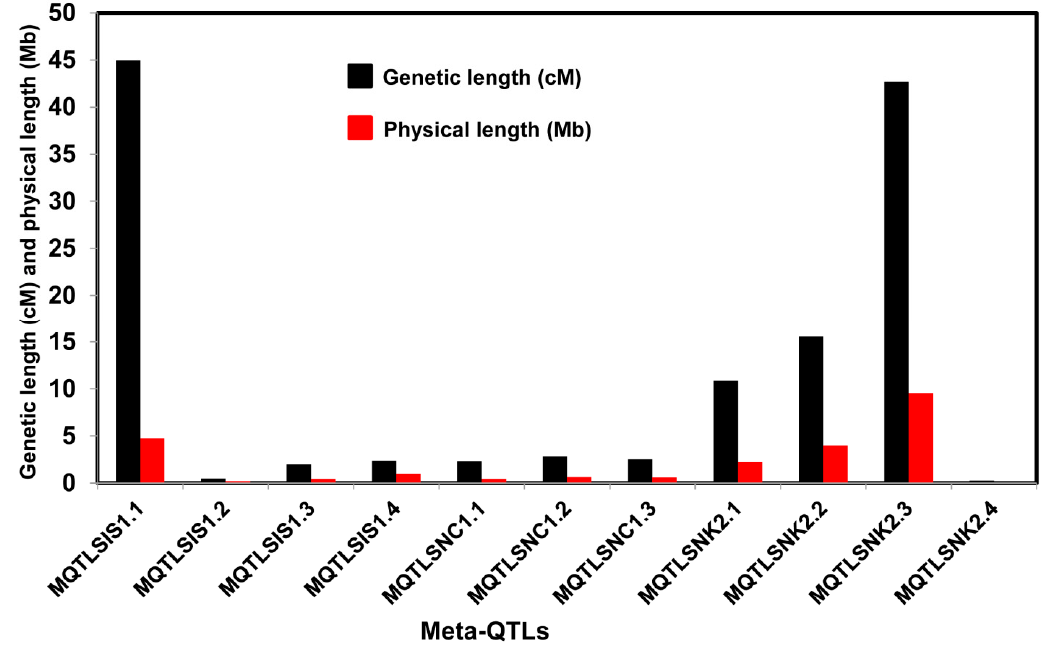
Figure 5. Genetic and physical length of the meta-QTLs. Black bars demonstrate the genetic length (cM) and red bars indicate the physical length (Mb) of the meta-QTLs.